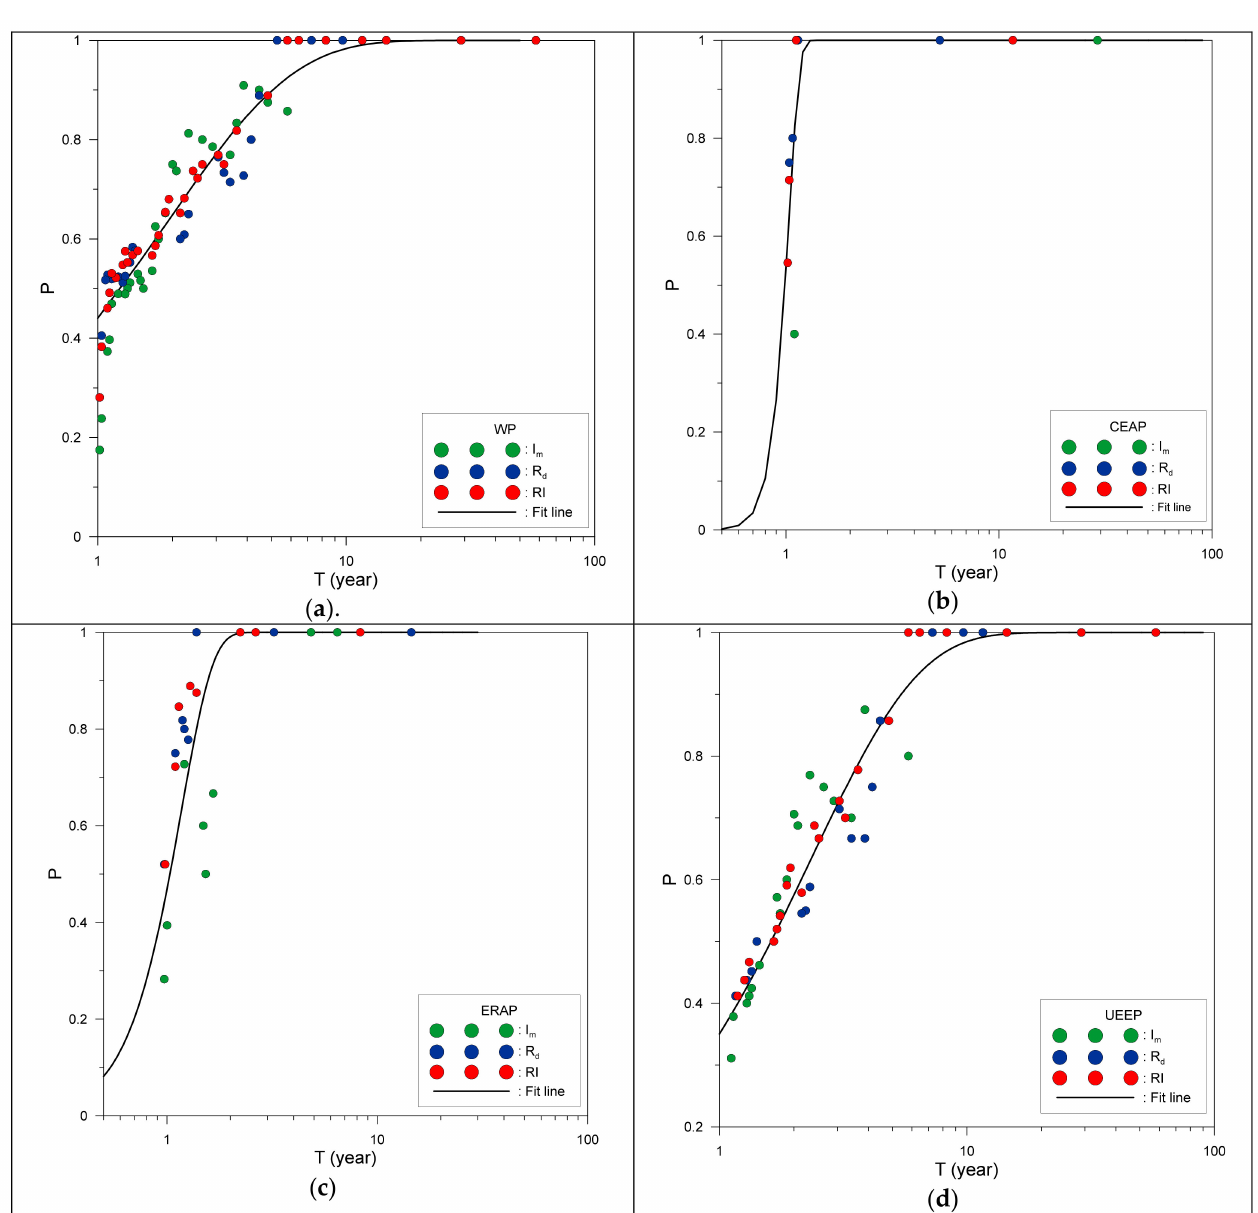
Figure 4. Four models describing the relationship between the probability of debris flow occurrence (P) and the rainfall return period (T). Data for T were determined from historical maximum annual hourly rainfall (I m ), maximum 24-h rainfall (R d ), or R d × I m (RI). ( a ) Whole period (WP); ( b ) Chi-Chi earthquake-affected period (CEAP); ( c ) extreme rainfall-affected period (ERAP); and ( d ) unaffected by extreme events period